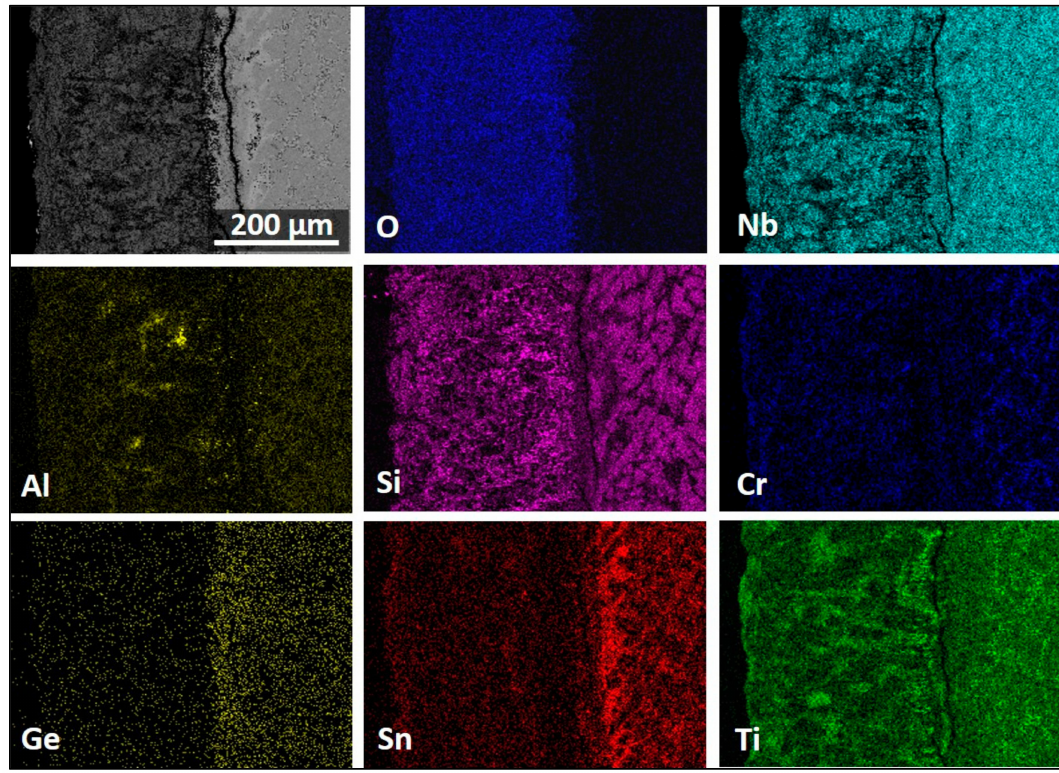
Figure 12. BSE image and X-ray elemental maps of a cross-section of the alloy OHS1 after isothermal oxidation in air at 1200 ◦